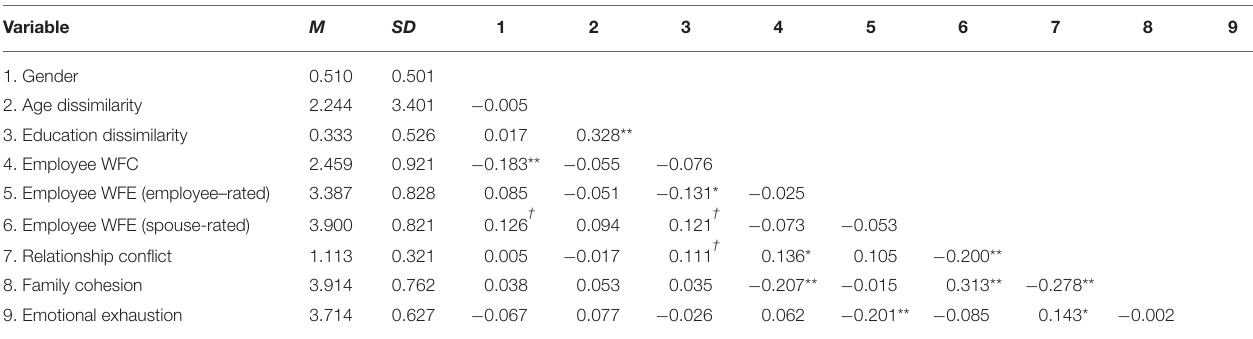
TABLE 1 | Means, standard deviations, and correlations among variables.